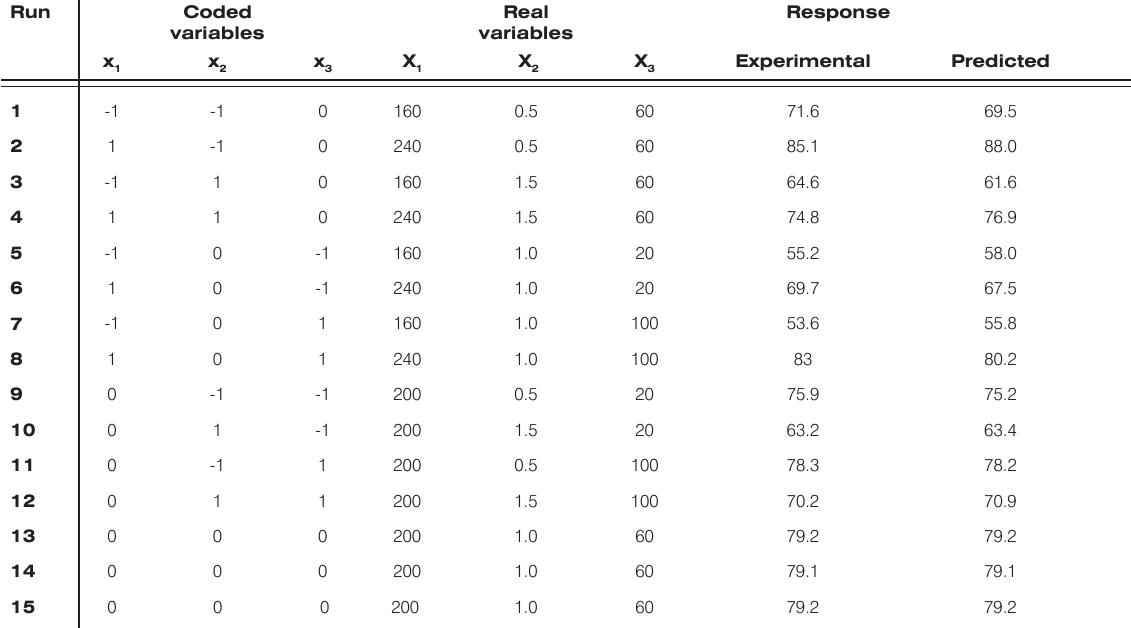
Table 3. Experimental and predicted oxidation efficiencies under different conditions.